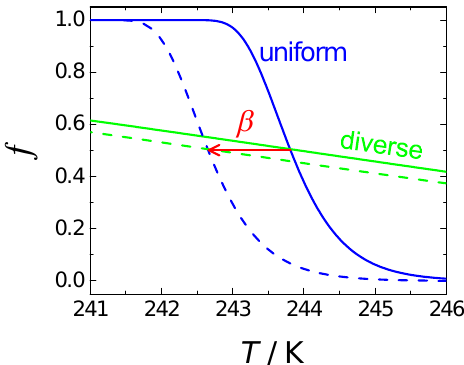
Figure 3. A direct relationship between λ ( − dln( J s ,i ) /d T ) and β (the shift in freezing temperature upon a factor of 10 change in cooling rate) is observed for all droplet cooling simulations. For each set of runs λ was systematically increased whilst the following variables were set: mean ( µ ) and standard deviation ( σ) of the PDF, surface area of particle per droplet ( A ), and the fraction at which the change in temperature was calculated ( f ). More information can be found in Table